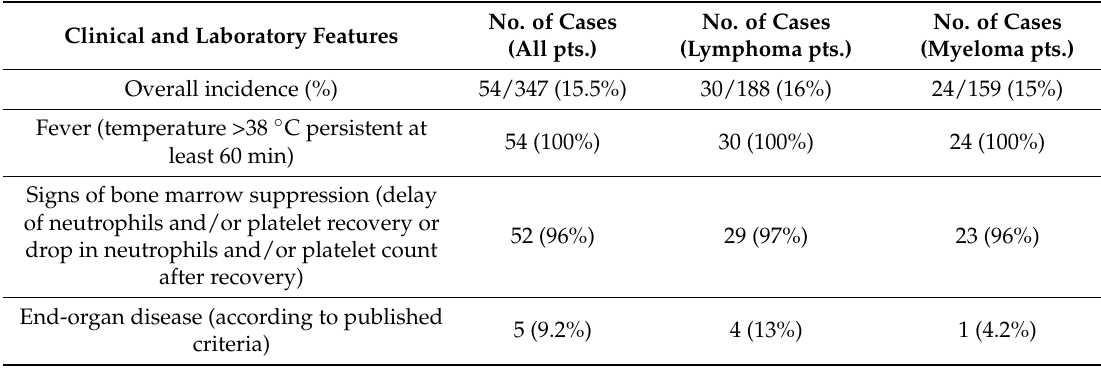
Table 3. Clinical and laboratory features and outcome of CMV reactivation episodes requiring specific antiviral